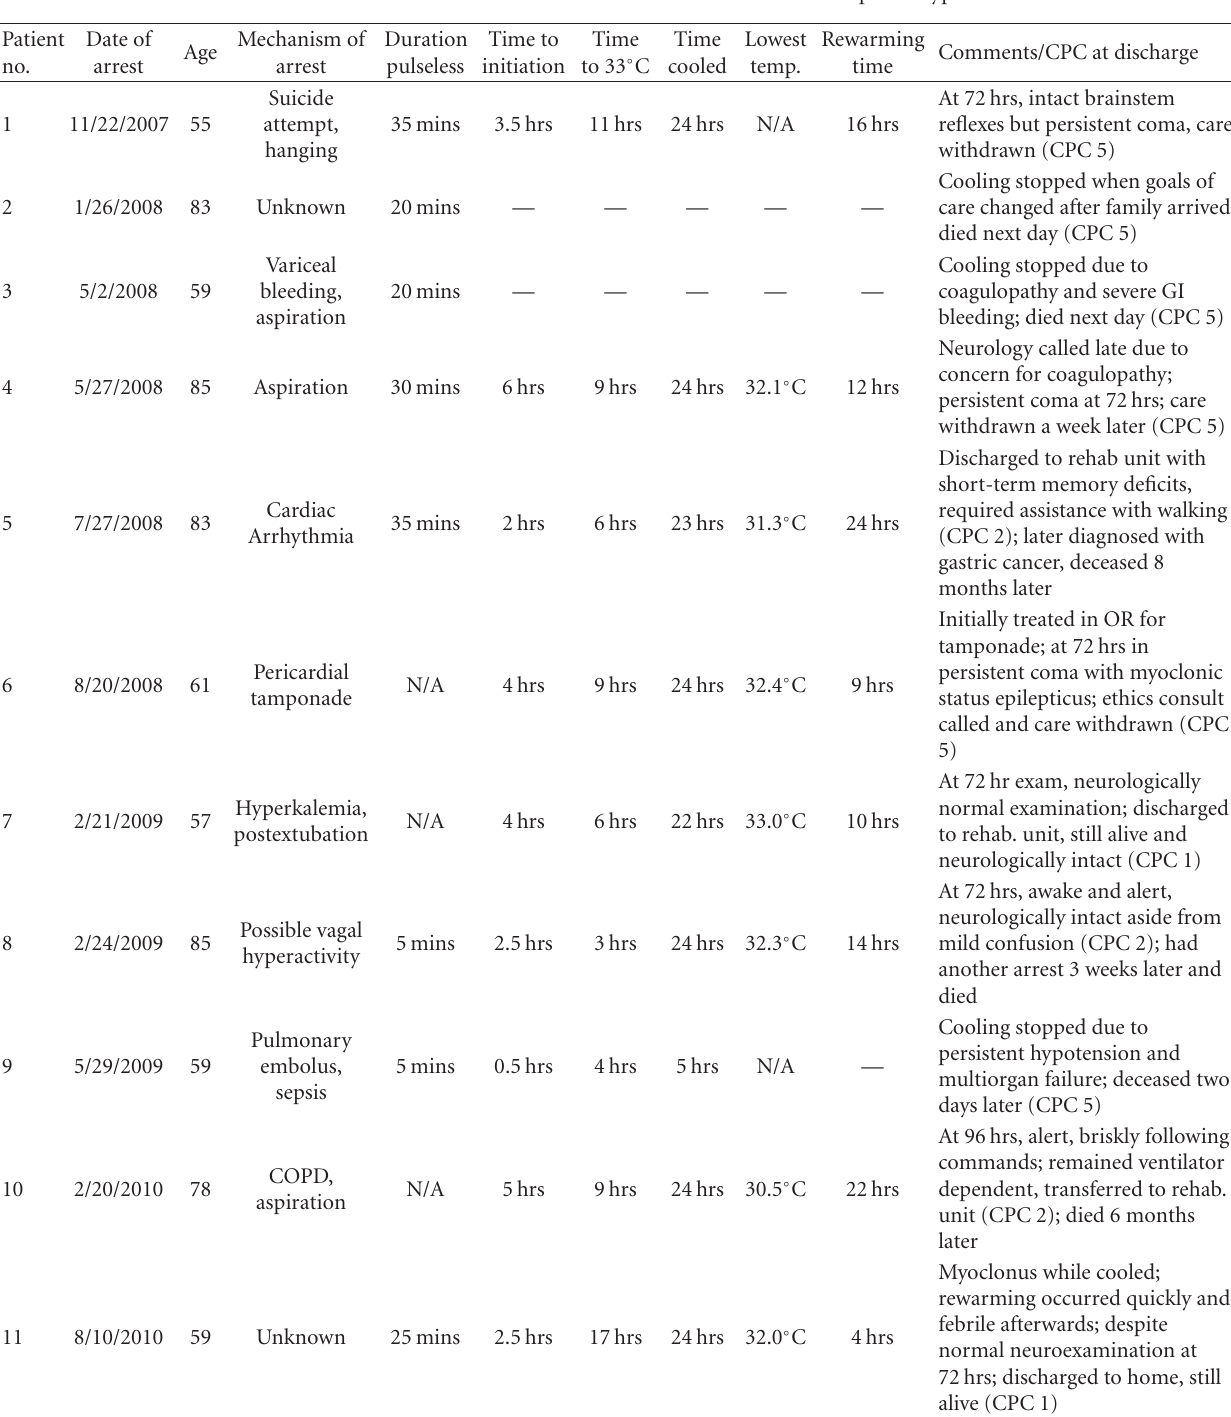
Table 2: Comatose survivors of cardiac arrest that were treated with therapeutic